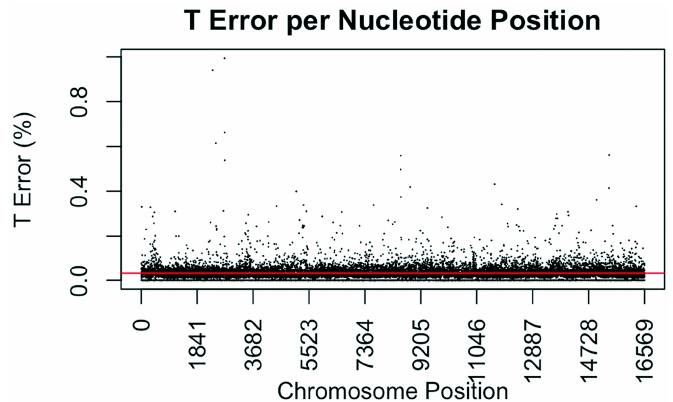
Figure 3. Substitution error rate for G (guanosine) nucleotides per nucleotide position across the mtDNA genome. The error rate was calculated as described in Figure 1. The red line indicates the average G error (0.0331%) for all nucleotide positions.